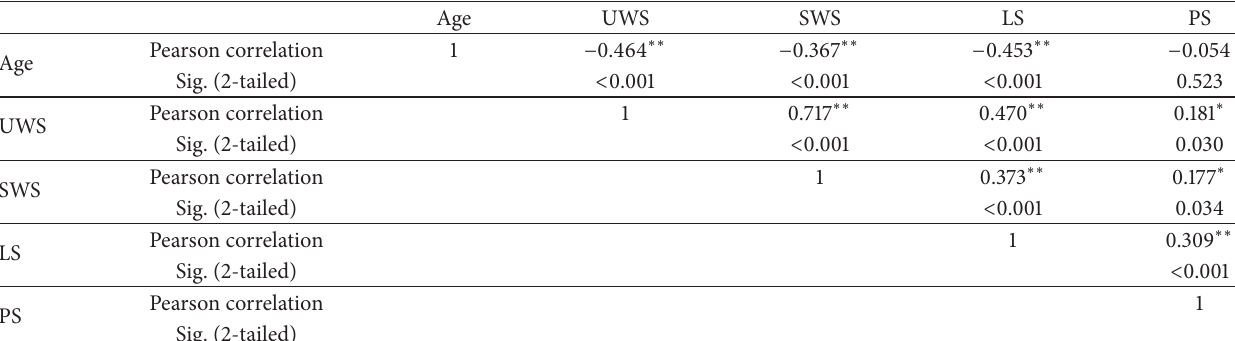
Table 1: Correlations among salivary flow